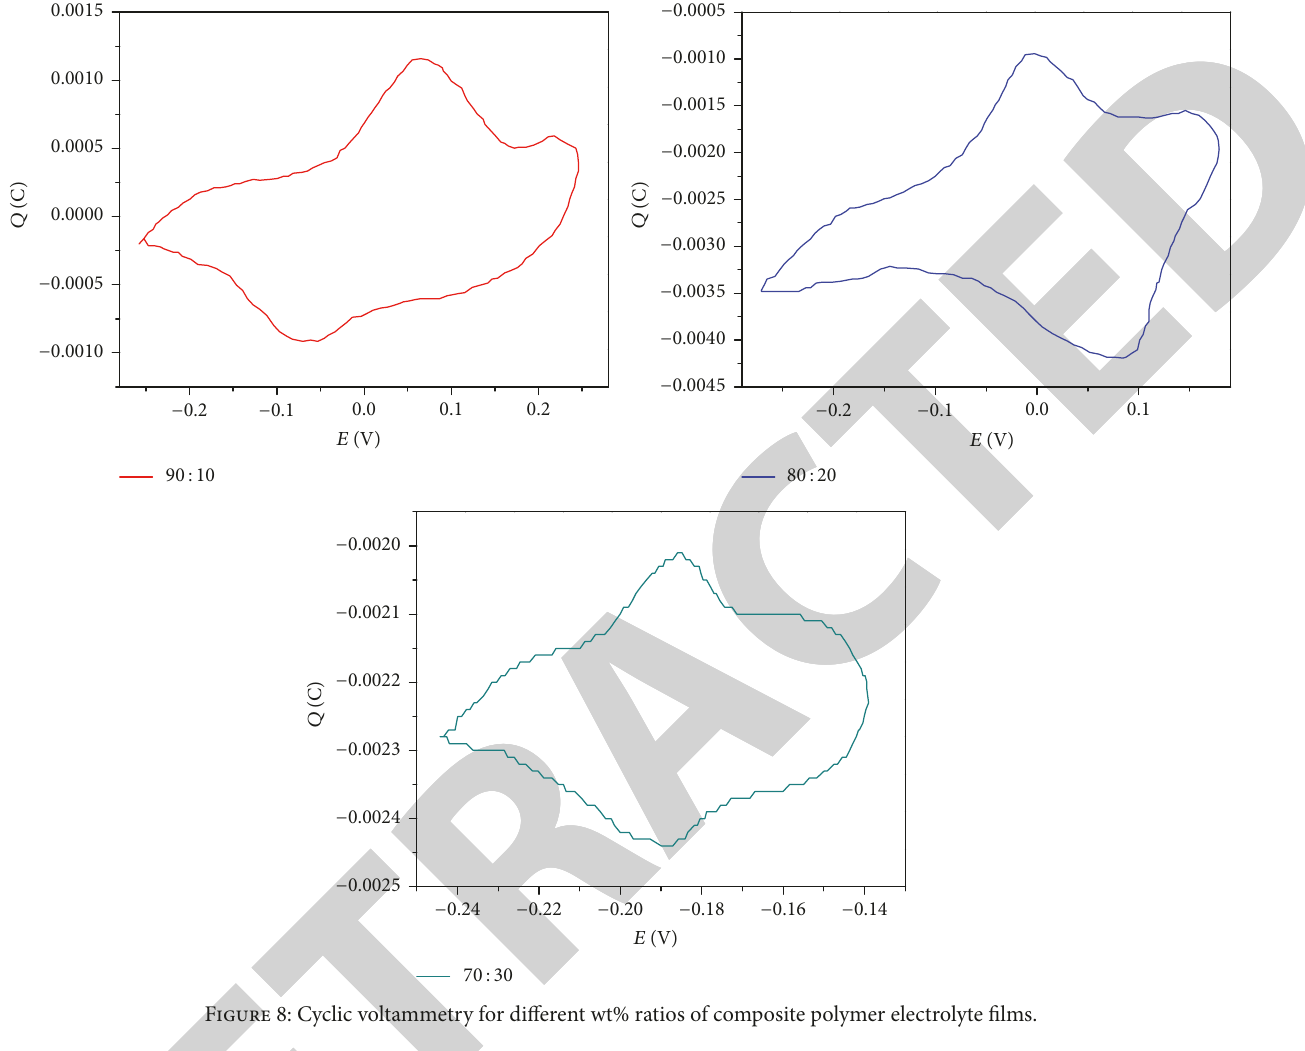
Figure 8: Cyclic voltammetry for different wt% ratios of composite polymer electrolyte